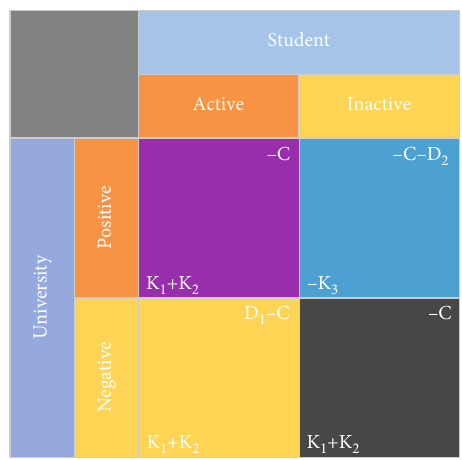
Figure 7: The game matrix grid between student 1 and student